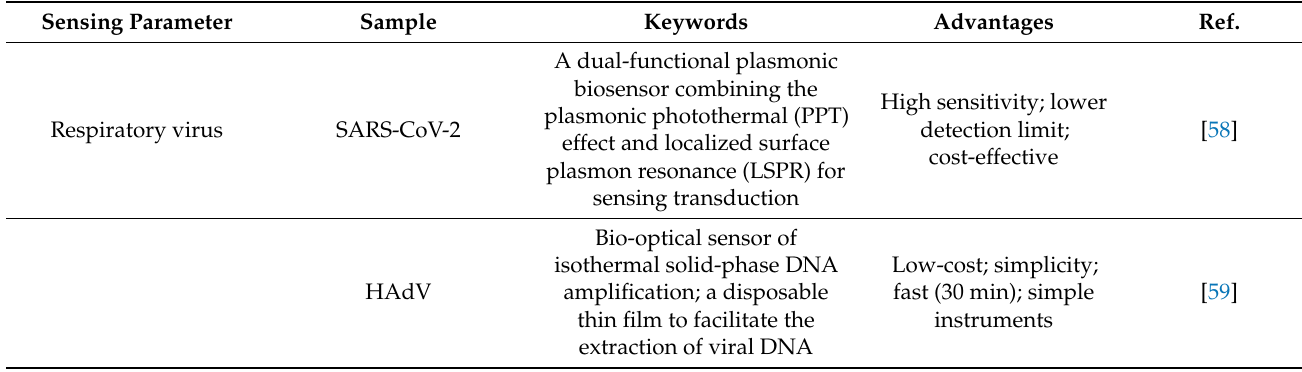
Table 2. Literature review of some biosensor-based microfluidic chips for lung disease modeling. Detailed sensing parameters and characteristics of corresponding sensing technology are listed for summary. Sensing Parameter